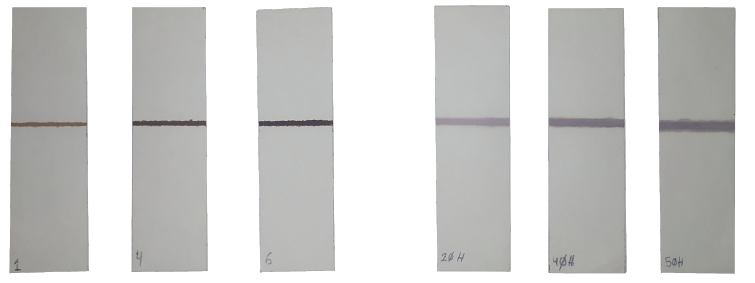
Figure 5. ( Left ) some magnetite NP samples; ( right ) some gold NPs samples. In all cases, NPs were deposited on blotting paper and placed on the sensing coil in the experimental setup.